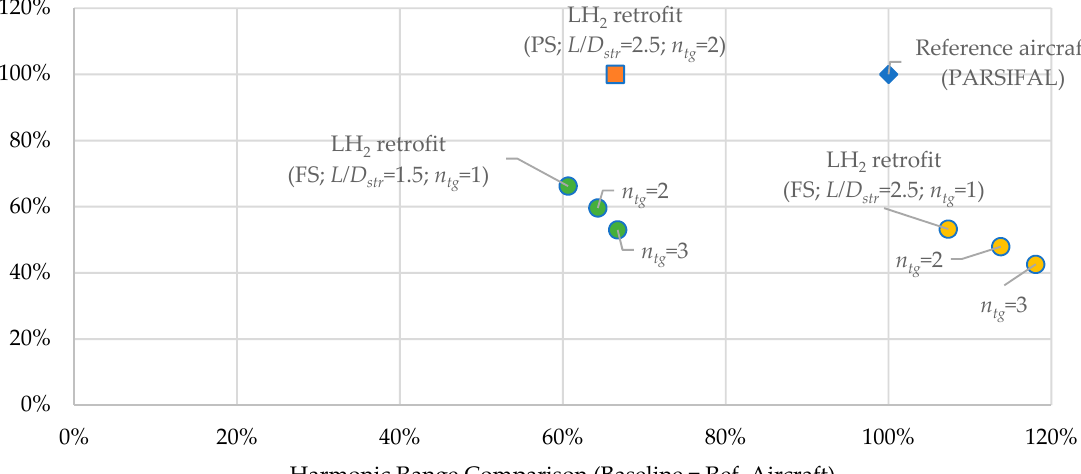
Figure 23. Summary of transport capabilities for some of the investigated LH 2 aircraft configurations compared to the reference aircraft (308 pax, 5722 km), for both part-section (PS) and full-section (FS) integration layouts.